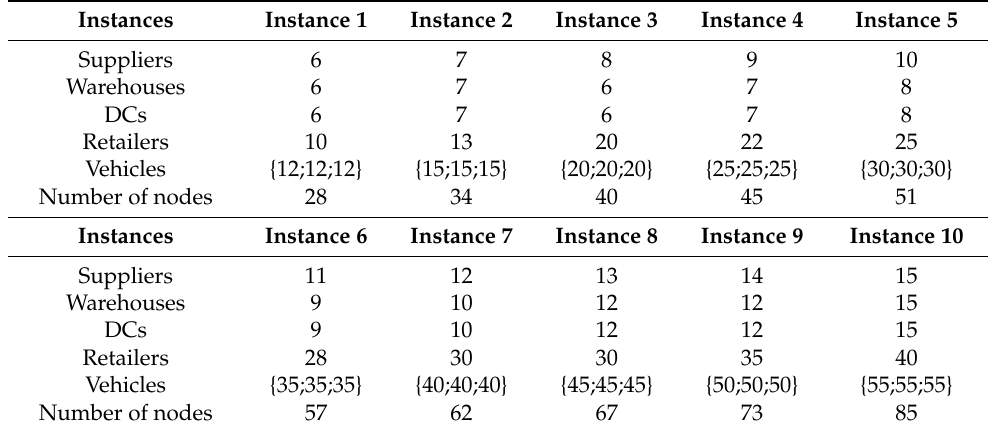
( d ) Figure 16. Comparison of the algorithms used in the different instances of the environmental scenarios. ( a ) Execution time of Sc1_env; ( b ) GAPs of Sc2_env; ( c ) Execution time of Sc2_env; ( d ) GAPs of Sc2_env. These curves show that the GA had the best performance with a GAP less than 2%, for the economic scenario, and less than 4% for the environmental one, for all instances. Sometimes, the SA gave better GAPs than all the other algorithms. The example of the I5